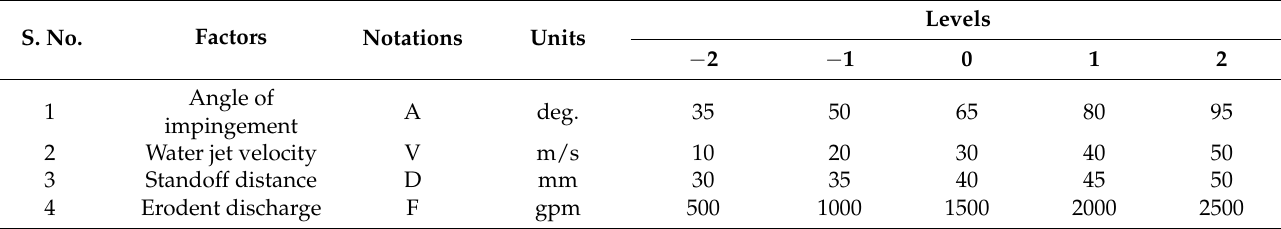
Table 3. Water jet erosion test parameters and their levels.